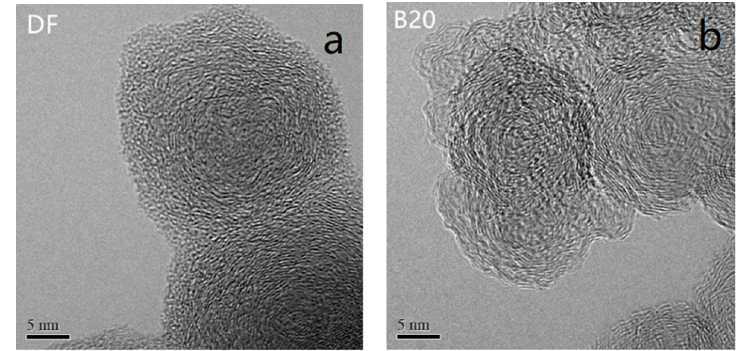
Figure 4. Typical HRTEM images of diesel particles sampled at BMEP = 0.782 MPa: ( a ) DF, ( b ) B20. The distribution histograms of L a , d s and T f for both DF and B20 soot are provided in Figures 5–7. The PDFs overlaid on the distribution histograms follow a lognormal distribution, and are nearly monodispersed. For a given test mode, the L a , d s and T f values for both soots are within the ranges of 0.2–5.0 nm, 0.30–0.46 nm and 1.0–1.8 respectively. As a general observation, it is difficult to establish